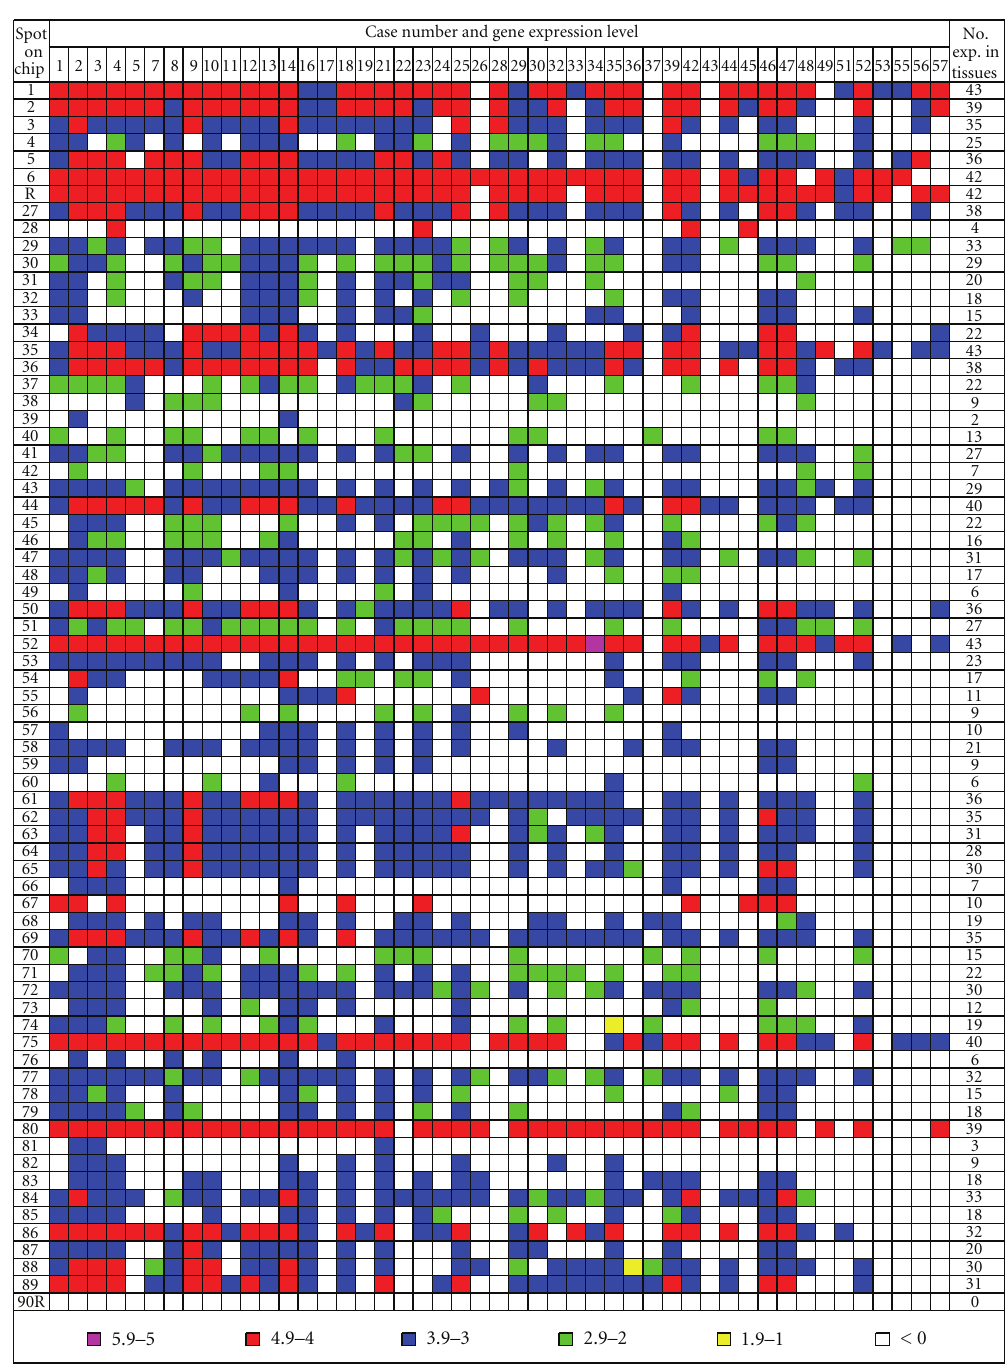
Figure 2: Hierarchical presentation of EBV gene expression patterns in forty-seven OSCC specimens. The EBV gene expression patterns in the OSCC tissues were presented by colored codes, as pink, red, blue, green, and yellow squares represented log numbers in the respective ranges of 5.9 - 5.0, 4.9 - 4.0, 3.9 - 3.0, 2.9 - 2.0, 1.9 - 1.0, and < 0, with larger numbers denoting greater expression levels. Among the 47 tissue specimens, the total numbers of samples that expressed the particular viral genes were counted and listed on the left (No. exp. in